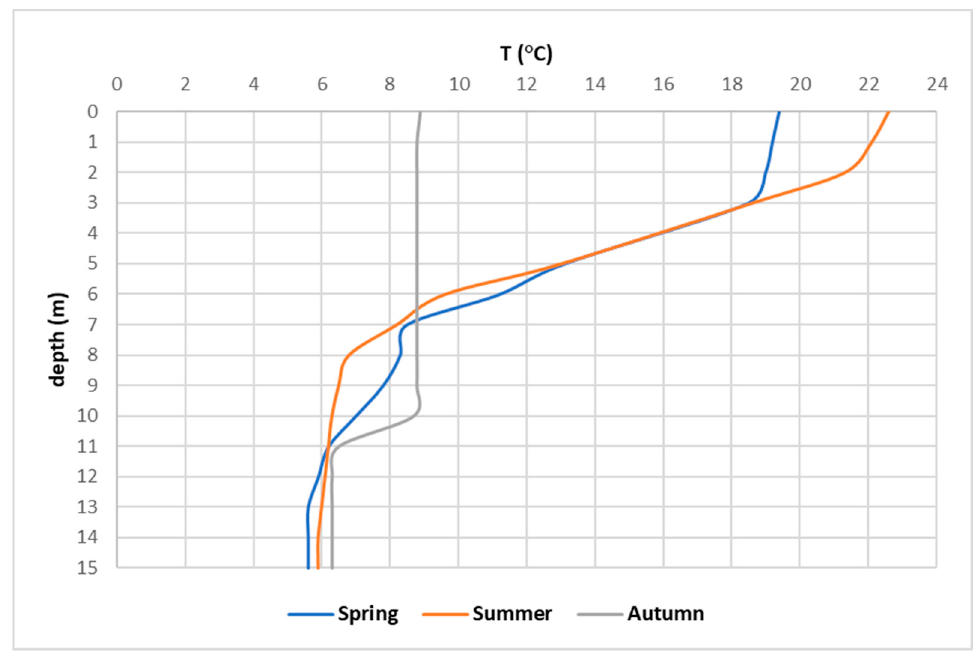
Figure 4. Annual (2018) thermal settings in Mi ł kowskie Lake.